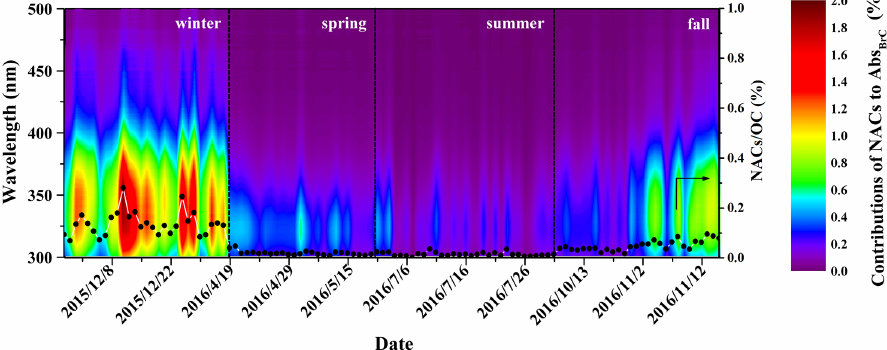
Figure 6. Time series of the light absorption contributions of total NACs to the absorption coefficient of brown carbon over wavelengths from 300 to 500nm (color scale and left axis) and the ratio of concentration of NACs to organic carbon (dots and right